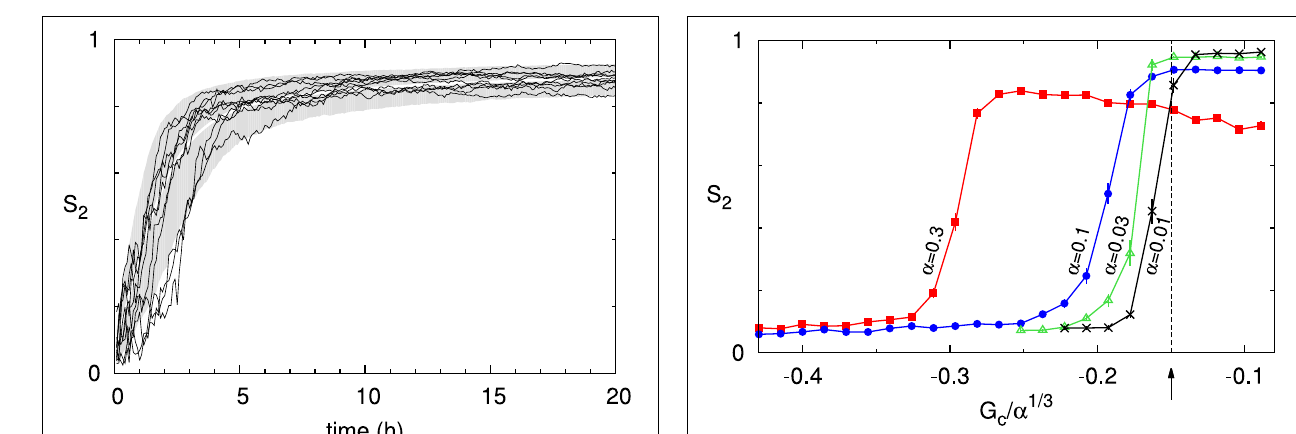
FIGURE 8 | Time evolution of microtubule alignment. S 2 order parameter of the same 1000 runs as in Figure 7 . The black curves show the results for 10 individual runs.